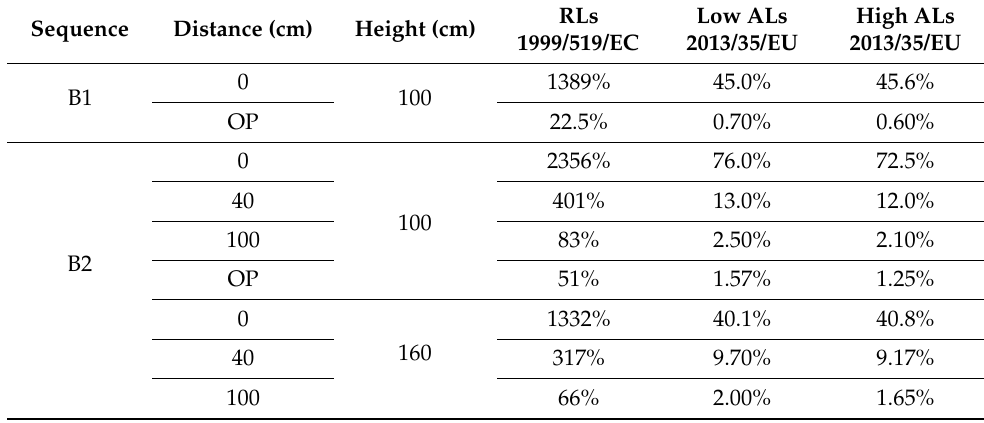
Table 6. Measurement results with the EHP-50F probe (WP mode, magnetic field, full scale of 100 µ T).